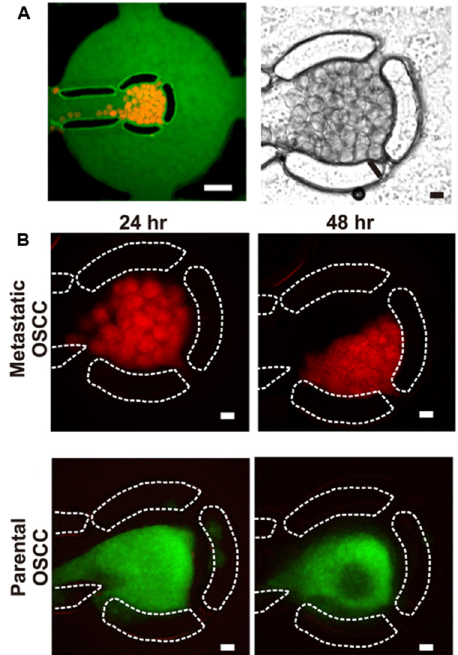
Figure 4. Visualization of metastatic oral squamous cell carcinoma (OSCC) spheroids immobilized within the cell culture chamber by ( A ) fluorescence (left) and light transmission (right) imaging. Culture medium was spiked with FITC-tagged BSA to visualize the cell culture chamber. Scale bar = 500 μ m. ( B ) Fluorescent images of metastatic and parental HN137 OSCC spheroids in the microfluidic device after 24 h and 48 h of perfusion culture. Scale bar 100 μ m. Reprinted with permission from Ref. [29]. Copyright 2009, IOP Publishing.